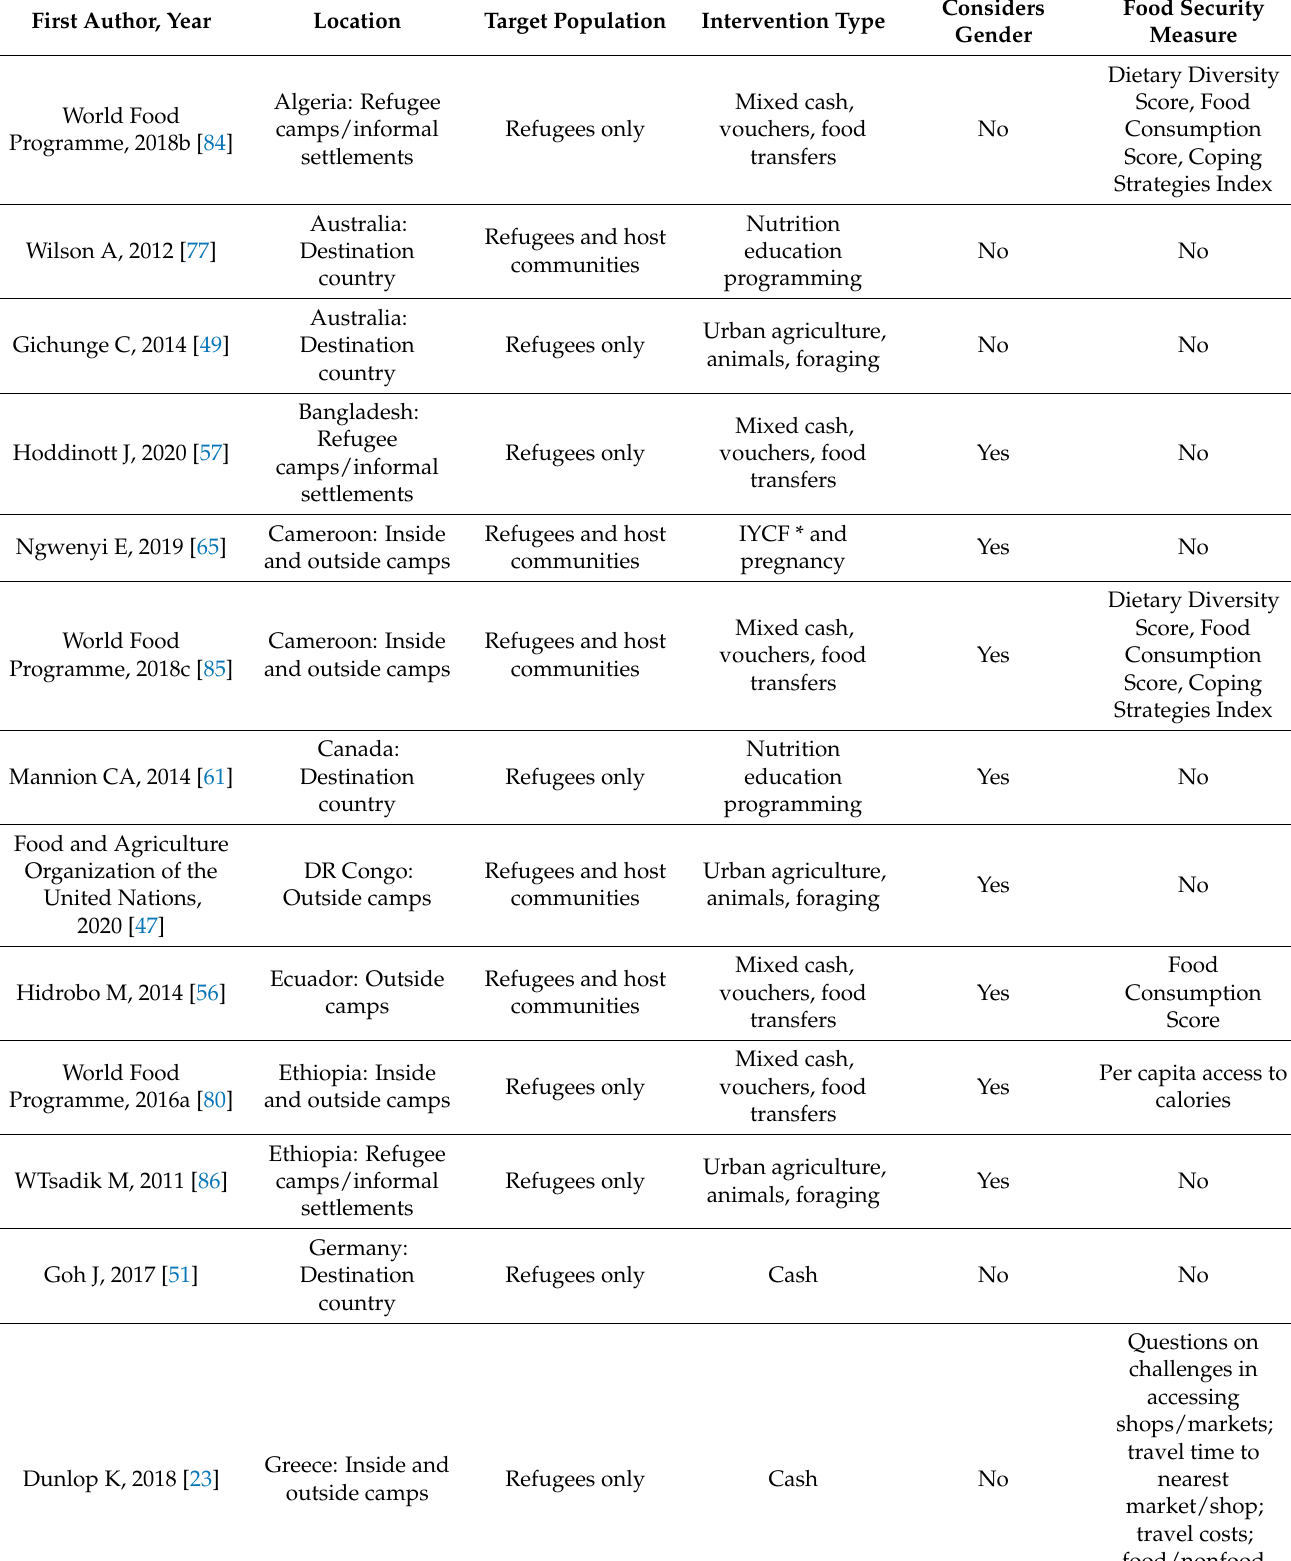
Table 2. Themes of eligible